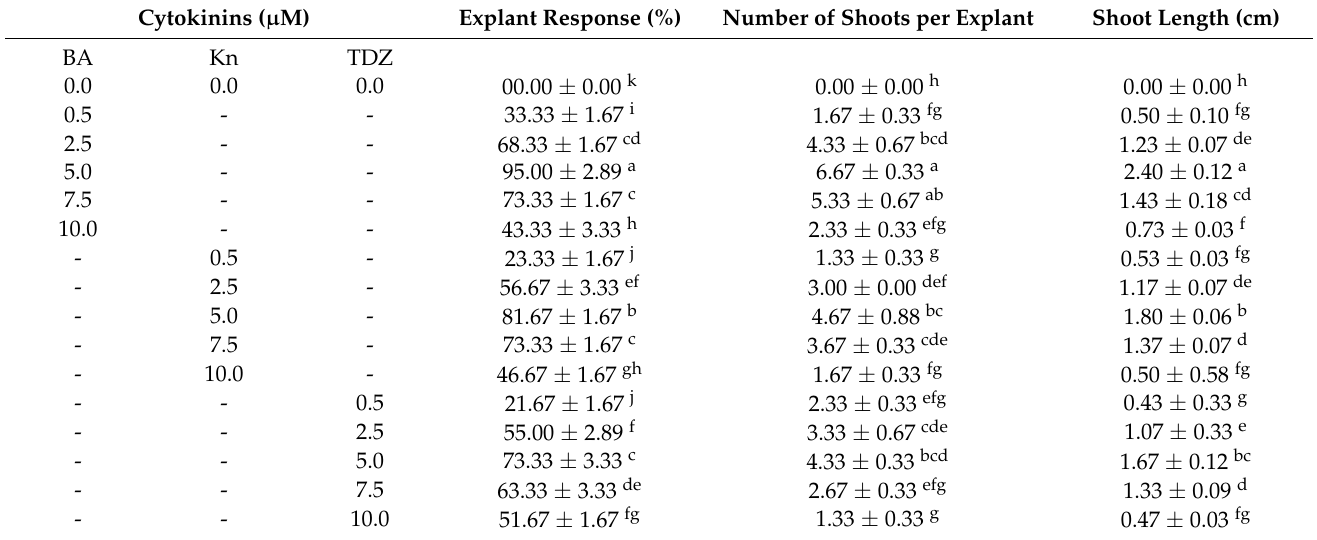
Figure 1. Regeneration of D. palmatus ( a ) NS cultured on MS + 5.0 µ M BA (Bar = 0.43 cm); ( b ) Multiple shoot initiation and regeneration on MS + 5.0 µ M BA (Bar = 0.40 cm); ( c ) Proliferation of shoots on MS + 5.0 µ M BA + 2.0 µ M NAA (Bar = 1.03 cm); ( d ) Rooting on 1 MS + 1.0 µ M IBA (Bar = 1.25 cm); ( e ) Exposed view of a micropropagated plant (Bar = 1.64 cm); ( f ) The 2 regenerated plantlet hardened in Soilrite (Bar = 1.67 cm); ( g ) Successfully acclimatized plantlet in garden soil (Bar = 6.41 cm). Table 1. Effect of various cytokinins on regeneration of D. palmatus after six